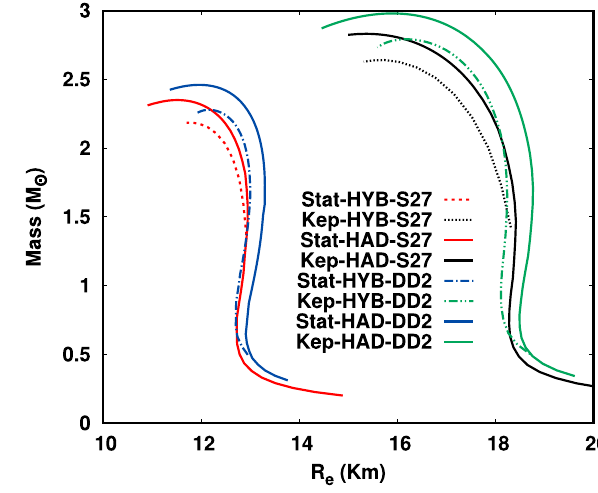
Fig. 1 Plot of pressure P as a function of the density ρ for 18 EoS using Gibbs construction. The change in slope in the Plot indicates the presence of a mixed-phase having quark and HM. The beginning of the